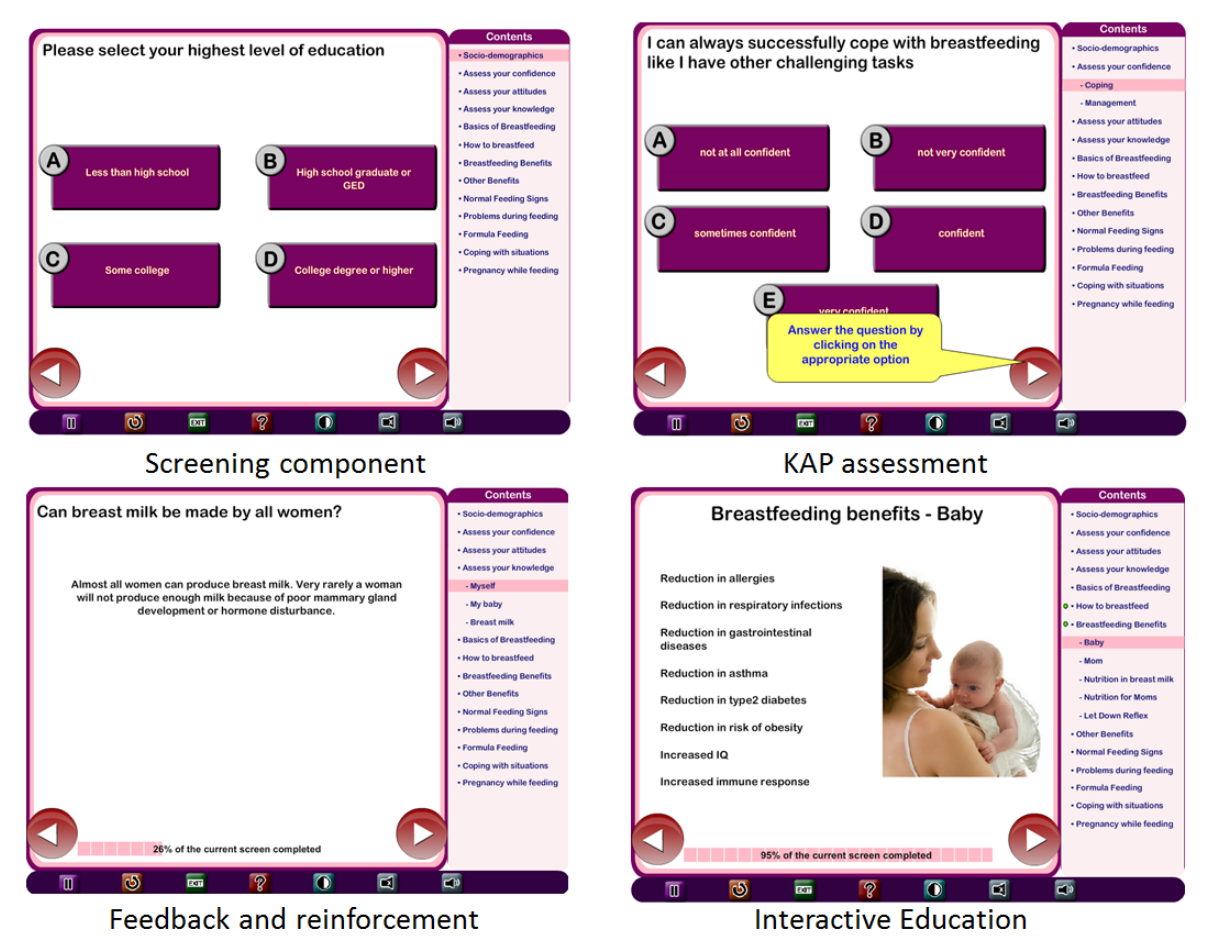
Figure 1. Components of computer based education